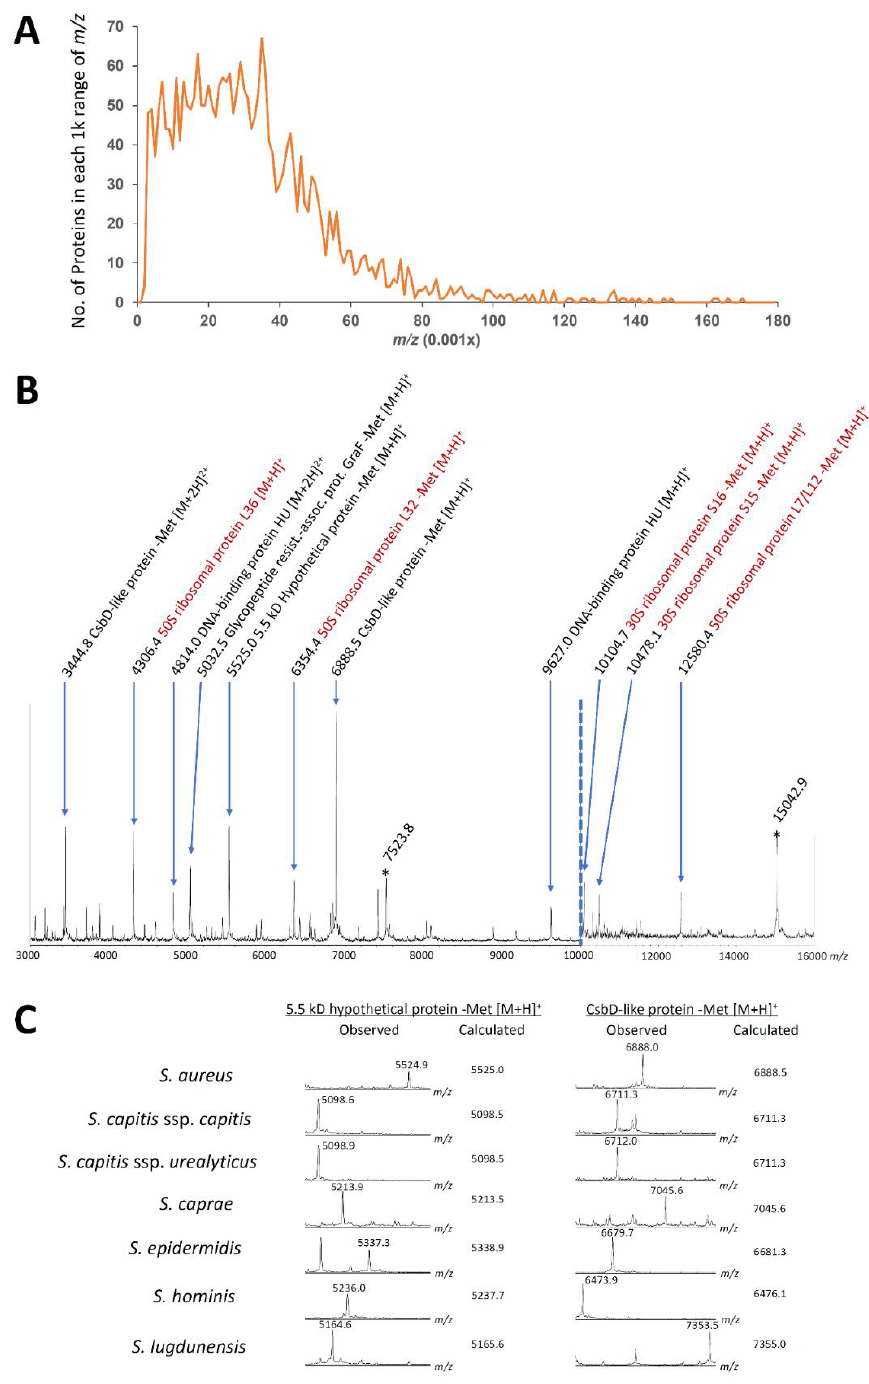
Figure 5. Assignment of prominent MALDI peaks of Staphylococcus aureus . ( A ) Number of proteins coded in the Staphylococcus aureus DSM 20231 T genome. Approximately 40–60 proteins are coded in each 1 kD range. This indicates that the protein assignment can be confirmed when a calculated peak fits an observed peak within the 500 ppm range for multiple species. ( B ) Peak assignment on the overall spectra of S. aureus CCUG 1800 T . Both x -axis and y -axis are different between 3000–10,000 m / z and 10,000–16,000 m / z ranges. Numbers before protein assignments are calculated m / z values (observed m / z values, see Table S4). Brown letters indicate ribosomal subunit proteins. -Met: methionine at N-terminus deleted from original translations. * Nutrition-dependent peaks yet to be identified (singly and doubly charged ions of the same protein). ( C ) Examples of assignment by comparing the observed and calculated peaks. The calculation was performed on Cutibacterium results, ribosomal subunit proteins coded on the S10-spc-alpha operon, and a 2D analysis report by Becher et al.